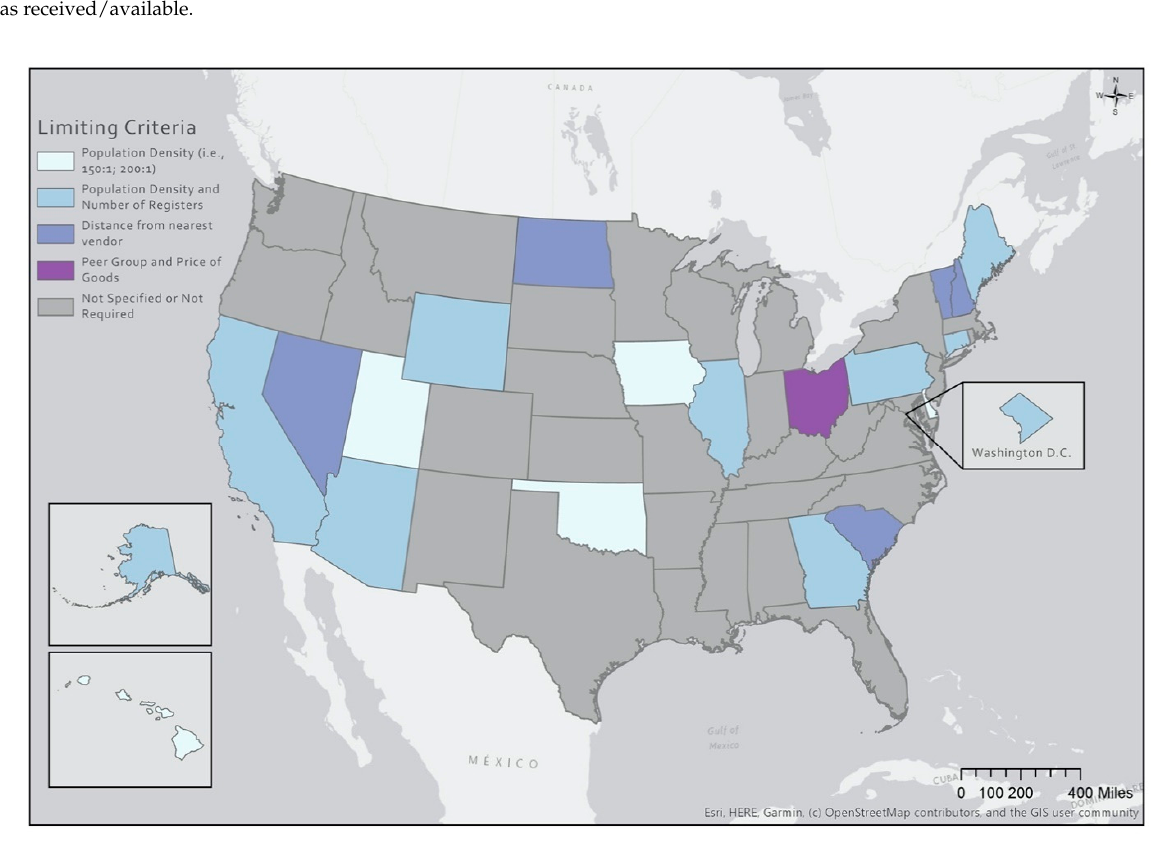
Figure 2. Limiting Criteria Adopted by State Agency-Authorized WIC Vendors, 2018–2020.